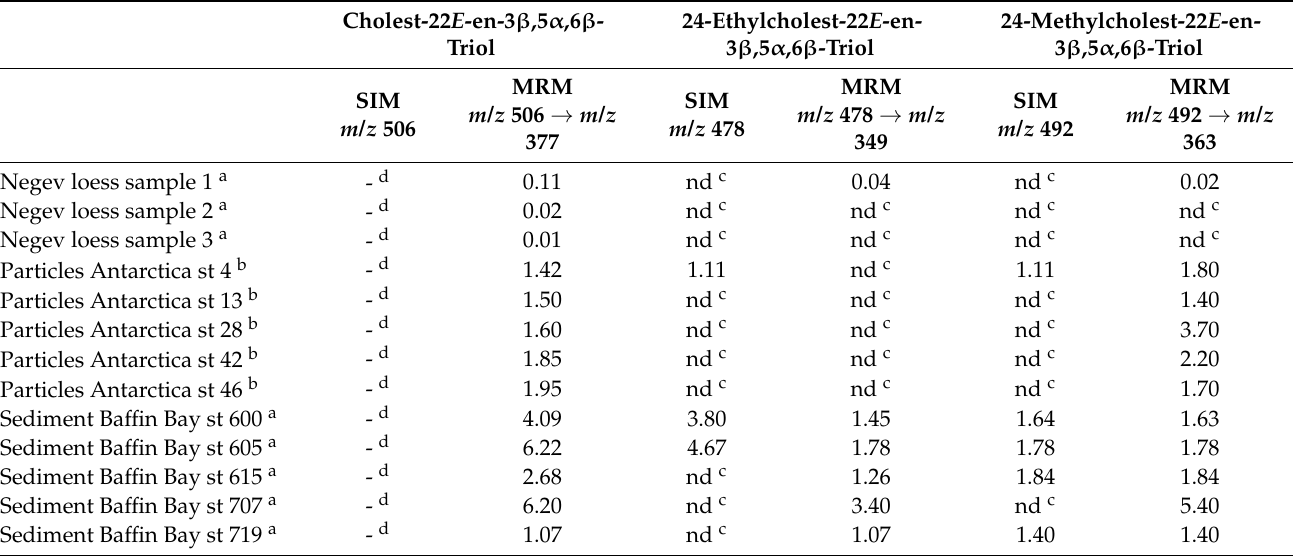
Table 5. Concentrations of unsaturated 3 β ,5 α ,6 β -steratriols in several environmental samples, mea- sured after trifluoroacetylation in SIM and MRM